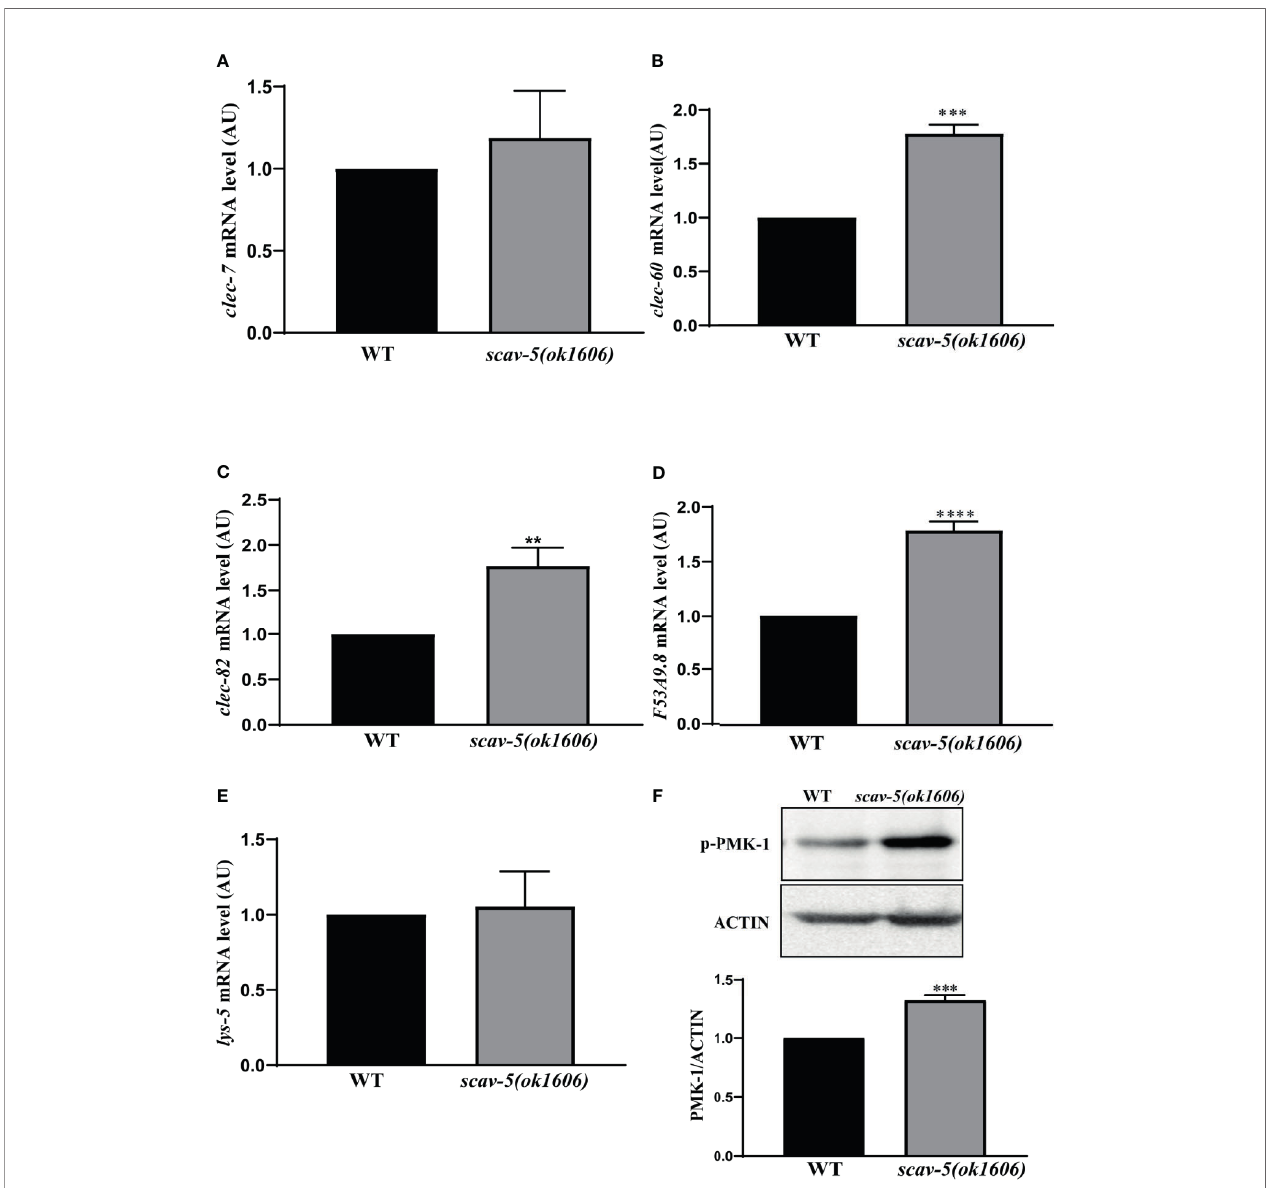
FIGURE 6 | PMK-1 signaling pathways are activated in scav-5 mutants after P. aeruginosa PA14 infection. (A) Immunoblot analysis of protein from young adult animals fed with P. aeruginosa PA14 24 h using antibodies that recognize the p-PMK-1 and actin. (B – F) qRT-PCR analysis of transcription level of pathogenic response genes clec-7 , clec-60 , and clec-82 (B – D) , lys-5 (E) , and F53A9.8 (F) in wild-type and scav-5(ok1606) animals cultured on P. aeruginosa